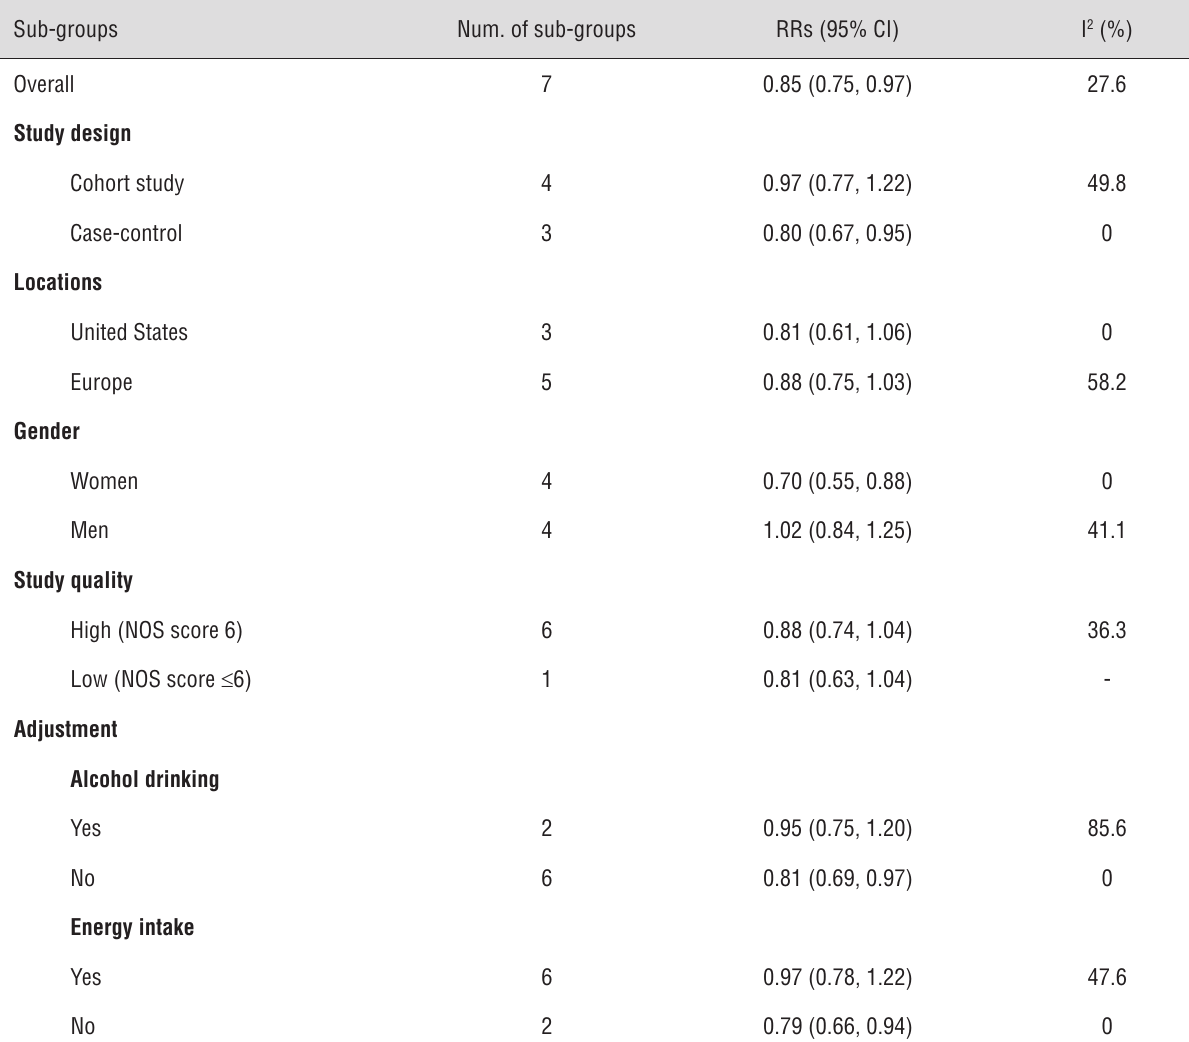
Table 2 - Subgroup analysis for dietary vitamin D intake and the risk of RCC.